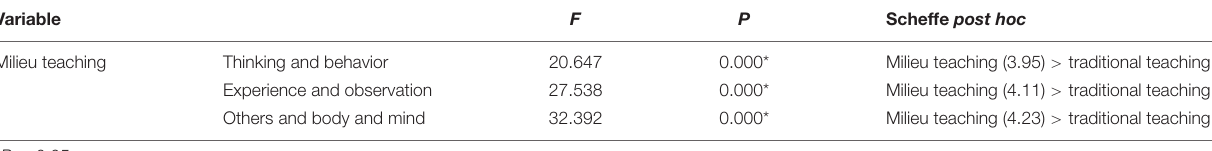
TABLE 2 | Analysis of variance of milieu teaching in language learning confidence. Variable